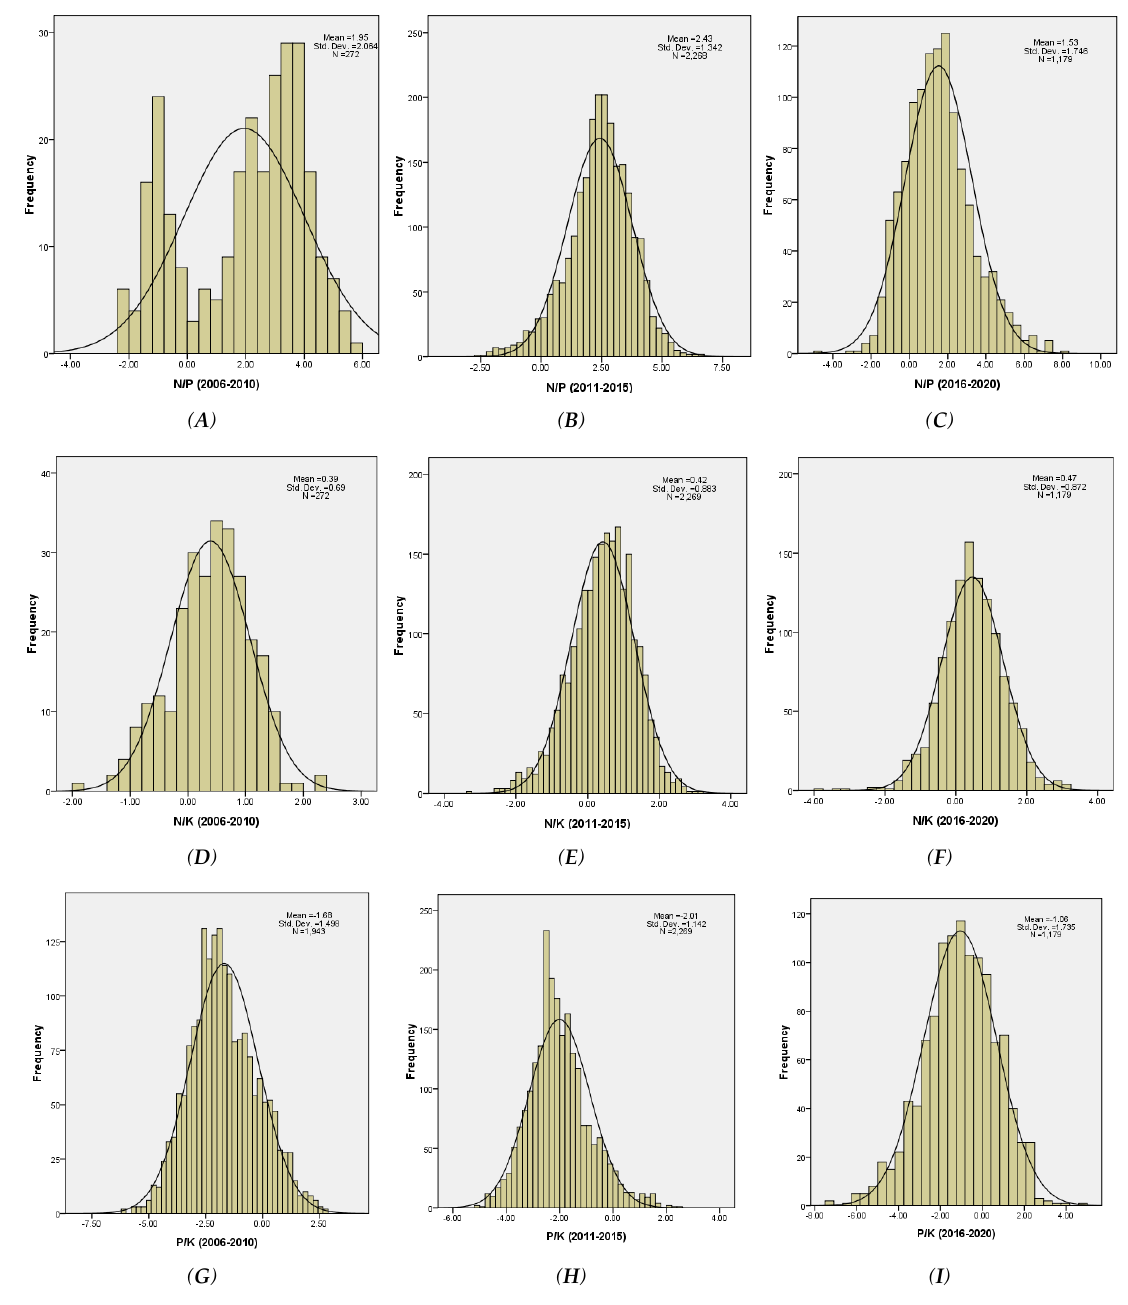
Figure 4. The density histogram of the ratio of N and P ( A ) for the 2006–2010 time period. The density histogram of the ratio of N and P ( B ) for the 2011–2015 time period. The density histogram of the ratio of N and P ( C ) for the 2016–2020 time period. The density histogram of the ratio of N and K ( D ) for the 2006–2010 time period. The density histogram of the ratio of N and K ( E ) for the 2011–2015 time period. The density histogram of the ratio of N and K ( F ) for the 2016–2020 time period. The density histogram of the ratio of P and K ( G ) for the 2006–2010 time period. The density histogram of the ratio of P and K ( H ) for the 2011–2015 time period. The density histogram of the ratio of P and K ( I ) for the 2016–2020 time